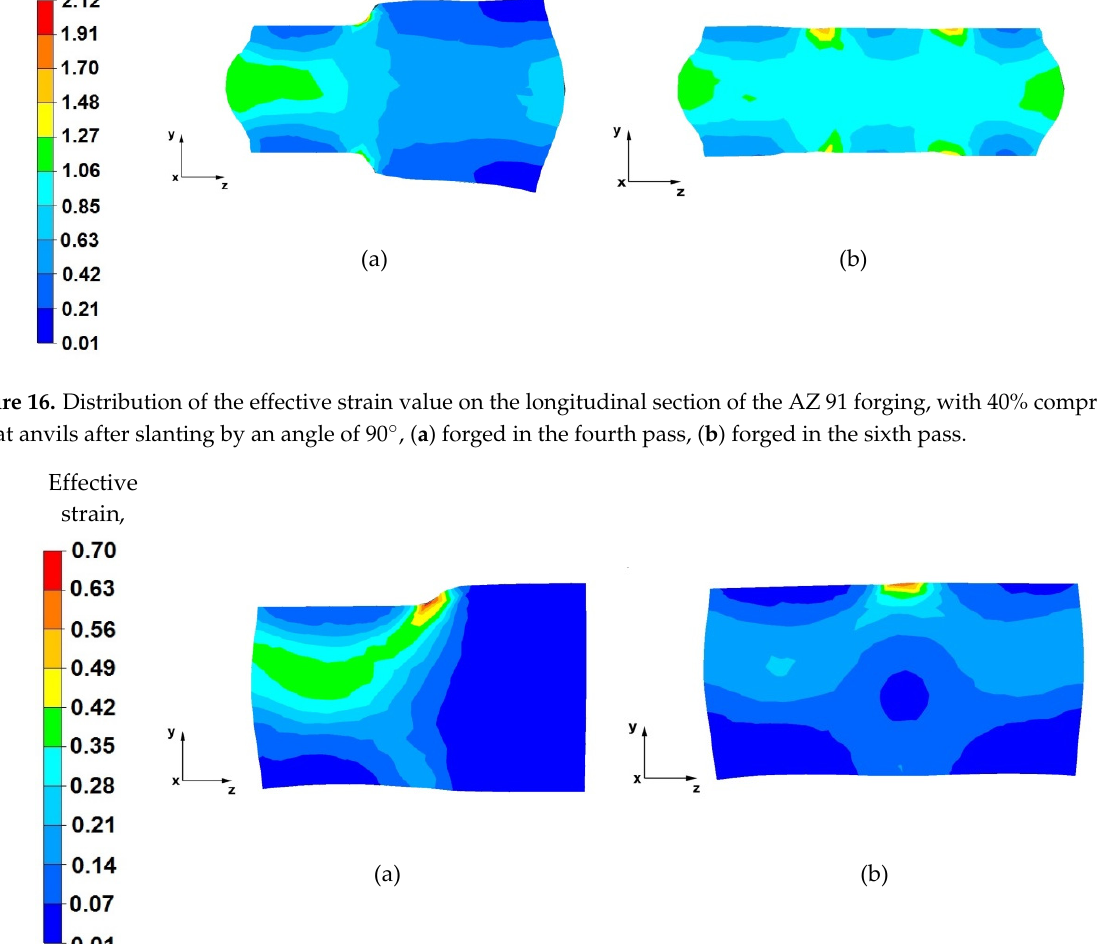
Materials 2021 , 14 , x FOR PEER REVIEW